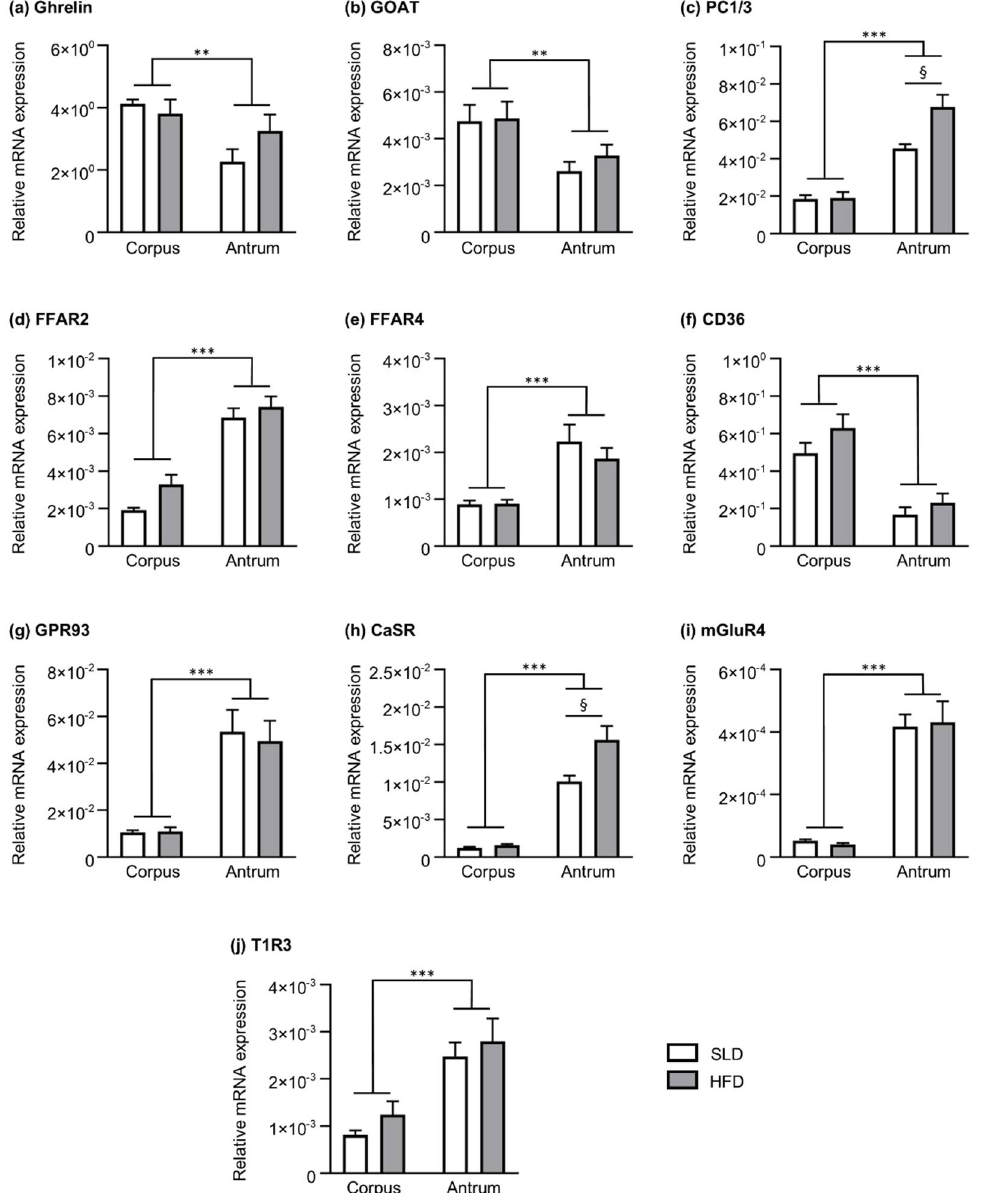
Figure 2. Nutrient chemosensors, ghrelin and ghrelin-processing enzymes relative mRNA expression in the corpus and antrum of a 12-week standard laboratory diet-fed (SLD, n = 5) or high-fat diet-fed (HFD, n = 5–7) mice. Relative mRNA expression of ( a ) ghrelin, the ghrelin-processing enzymes, ( b ) GOAT and ( c ) PC1/3, and the nutrient chemosensors for the detection of ( d – f ) fatty acids, ( g – i ) protein digestion products and ( j ) sweet and umami taste. The expression is relative to the average housekeeper values for PPIA, HPRT and B2M. Data are expressed as mean ± SEM. Differences in gene expression were determined by two-way ANOVA followed by Sidak post hoc test. Statistical significance for two-way ANOVA is defined as ** p < 0.01 and *** p < 0.001. Statistical significance for Sidak post hoc test is denoted as § p < 0.01.